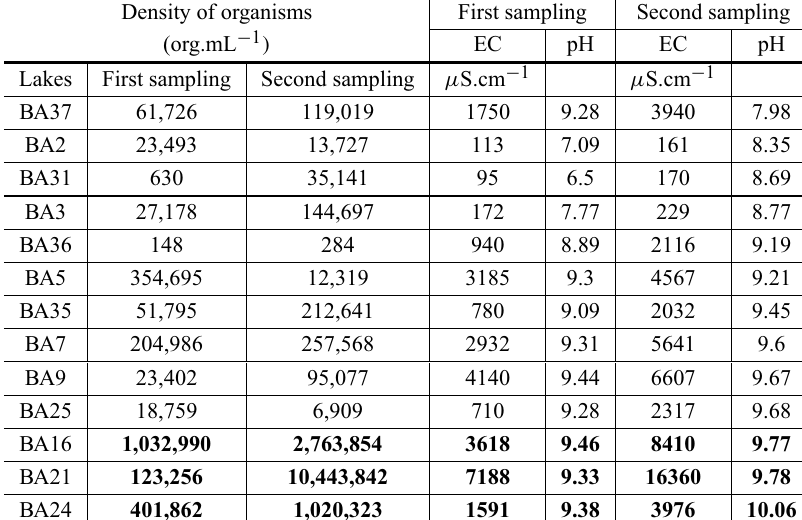
Density of organisms, EC and pH of the samples of October 2008. The highest pHs are related to the highest density of organisms in extreme dryness (bold characters and grey lines). Data ordered by pH of the second sampling. Density of organisms First sampling Second sampling (org.mL − 1 ) First sampling Second